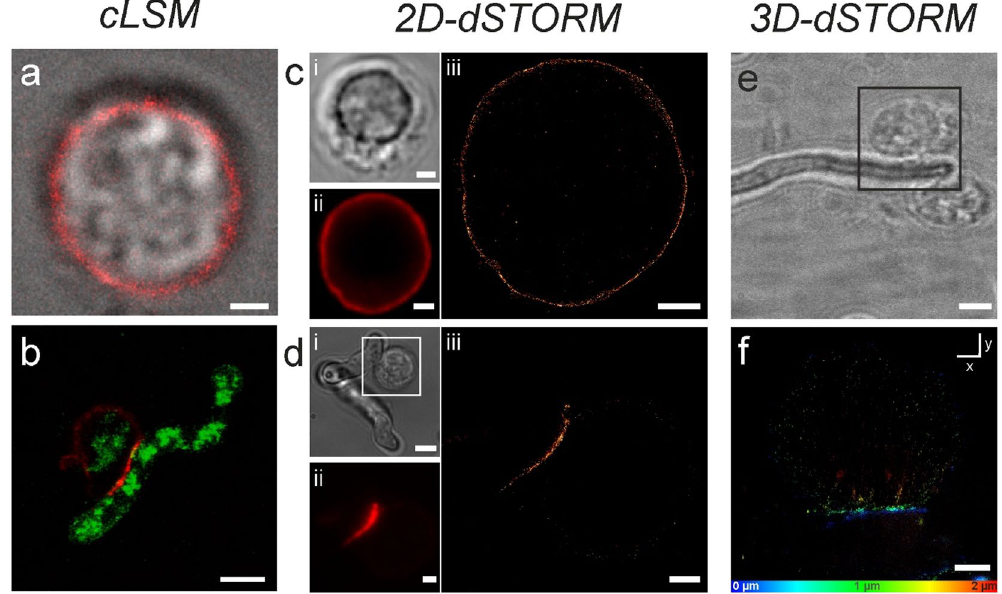
Figure 5. CD56 re-organization to the interaction site. NK cells and NK cells- A . fumigatus co-cultures were visualized with ( a , b ) CLSM, ( c , d ) 2D d STORM, and ( e , f ) 3D d STORM after staining with anti-CD56. NK cells were either left untreated ( a , c ) or incubated with A . fumigatus germ tubes (MOI 0.5) for 3 h ( b , d – f ). ( b ) Auto fluorescence was recorded to visualize NK cell- A . fumigatus interaction. Transmitted light pictures (ci, di), ( e ), widefield fluorescence images (cii, dii), and d STORM images (ciii, diii) of the interaction site were compared. In ( f ) the x-y projection of a reconstructed 3D dSTORM image is given which is color coded in z. ( e ) The transmitted light picture is a zoom out of ( f ) illustrating two NK cells which interact with A . fumigatus . Scale bars: 1.5 μ m ( c , dii,iii), 2 μ m ( b , f ), 3 μ m ( a , e ), 4 μ m (di), and 5 μ m ( b ). 3D stack showing interaction site of NK cell and A . fumigatus ( e , f ). NK cells were incubated for 3 h with A . fumigatus , thereafter stained with anti CD56- Alexa Fluor 647, and visualized in